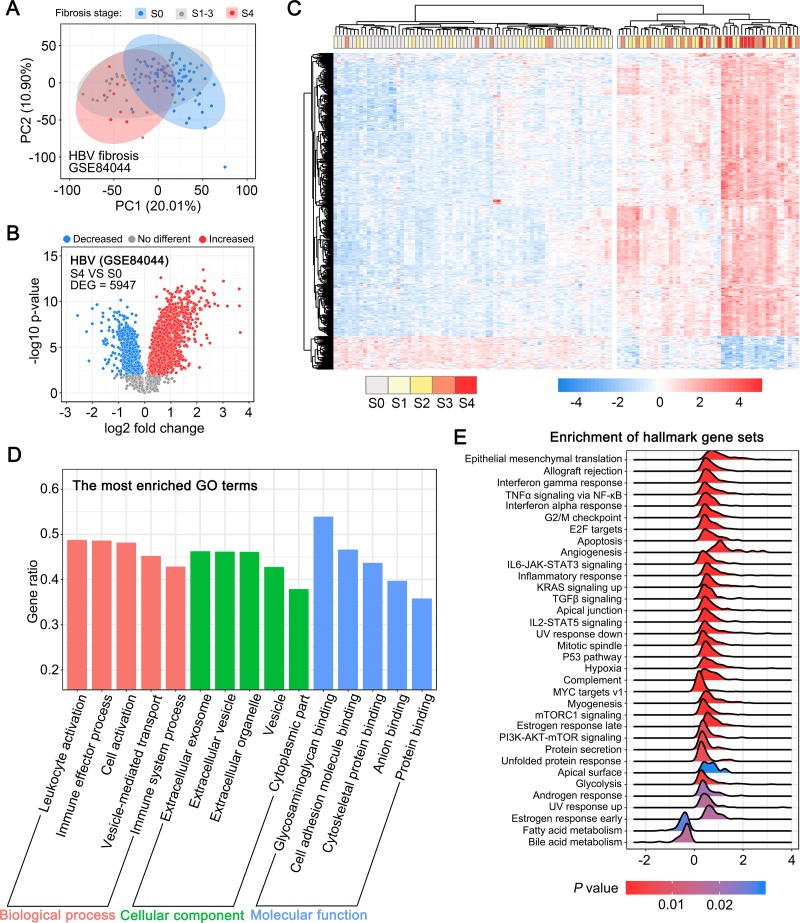
Gene expression profiles in HBV-associated fibrotic liver tissues.(A) Principal component analysis (PCA) of the normalized expression data in liver tissue samples from S0, S1-3, and S4 stage liver fibrosis. (B) Volcano plot depicting the differentially expressed genes (DEGs) between fibrotic liver tissues from stage S4 and S0 (P < 0.01). (C) Unsupervised hierarchical clustering of the top 426 DEGs (log2 Fold change > 1 or < -1) separated the samples into two major groups. (D) GO analysis of the DEGs between liver fibrotic tissues from stage S4 and S0. Each of the top 5 terms are indicated. (E) A ridgeline plot depicting the significantly enriched signaling pathways revealed by GSEA performed using 50 hallmark gene sets.